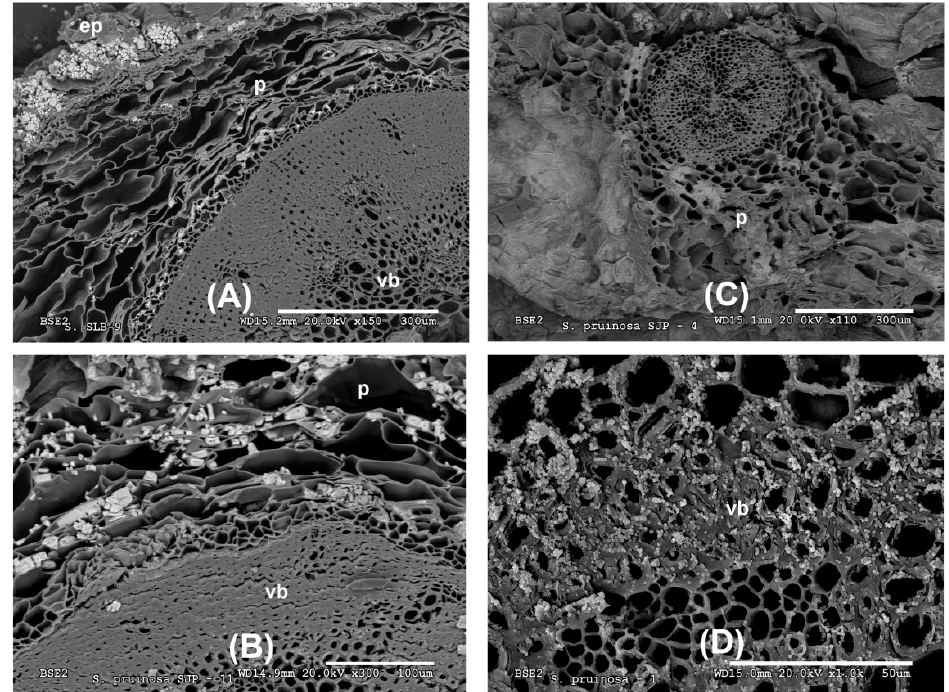
Figure 2. Representative SEM images of the tissue location of Na, K, Mg and Ca biominerals in S. pruinosa . ( A ) Stem cross section with Na and K salts. ( B ) Major salts of NaCl in parenchyma of transverse section of stem. ( C ) Location of Mg in parenchyma of flowering stem. ( D ) Vascular bundle showing abundant Ca crystals. Symbology: ep = epidermis; p = parenchyma; vb = vascular bundle.